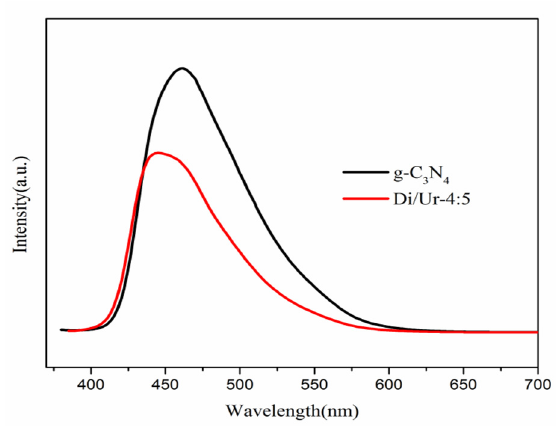
Figure 8. Photoluminescence (PL) spectra of pure g-C 3 N 4 and the Di/Ur-4:5 composite.